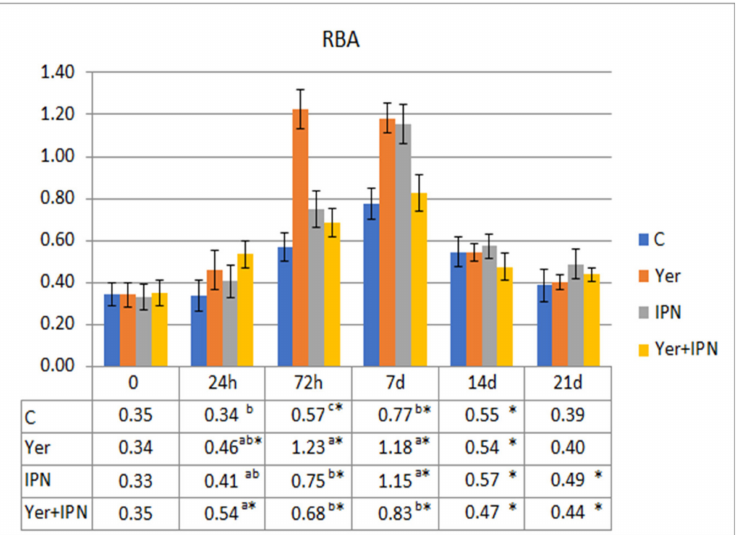
Figure 9. Mean values and standard deviation of metabolic activity of phagocytes over the course of the first experimental infection. *—statistically significant differences compared to the day 0 values within a given group ( p ≤ 0.05); a, b, c —statistically significant differences between the groups on a given sampling day ( p ≤ 0.05).